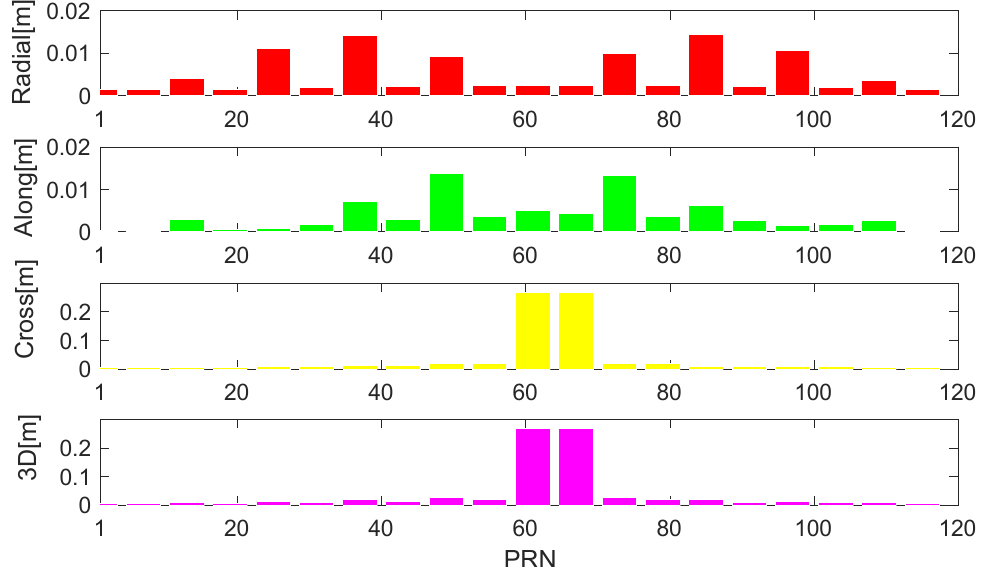
Figure 8. 120-LEO constellation orbital errors in radial, along-track, cross-track and 3D under 20 cm ranging accuracy, in which satellite of PRN 1, 7, 13, ... , 115 (divided at interval 6 of PRN number) are displayed.